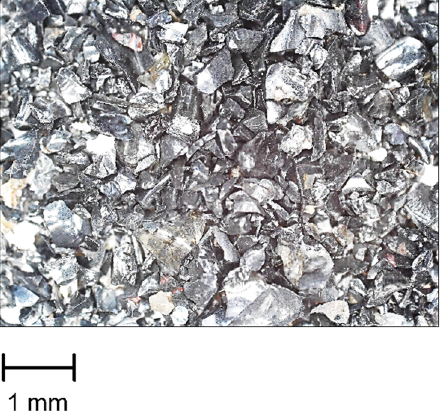
Figure 4. The sharp angular ‐ shaped grains of 0.125–0.63 mm copper slag abrasive (scale of 10:1)